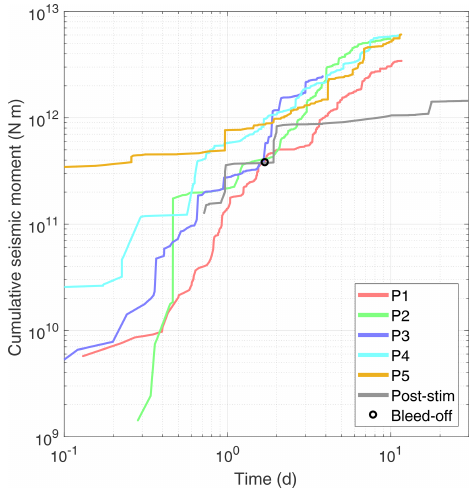
Figure 4. For a time period of 30d, the temporal evolution of cumu- lative seismic moment release for the relocated seismicity is shown for each injection phase and for the post-stimulation phase.